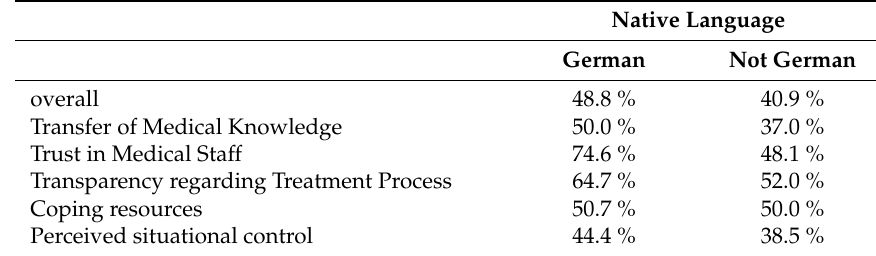
Table 5. Overall counselling success and in all five analytical dimensions depending on the parental native